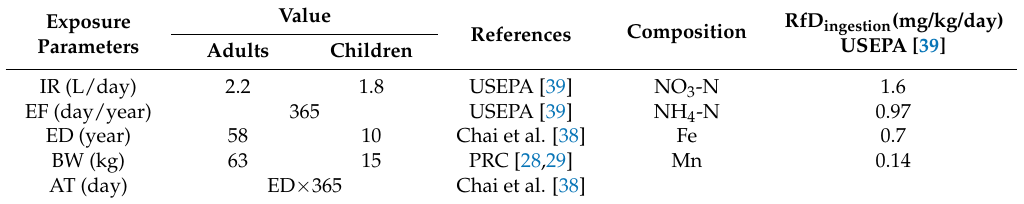
Table 3. The intake values of exposure parameters and RfD for the risk assessment due to